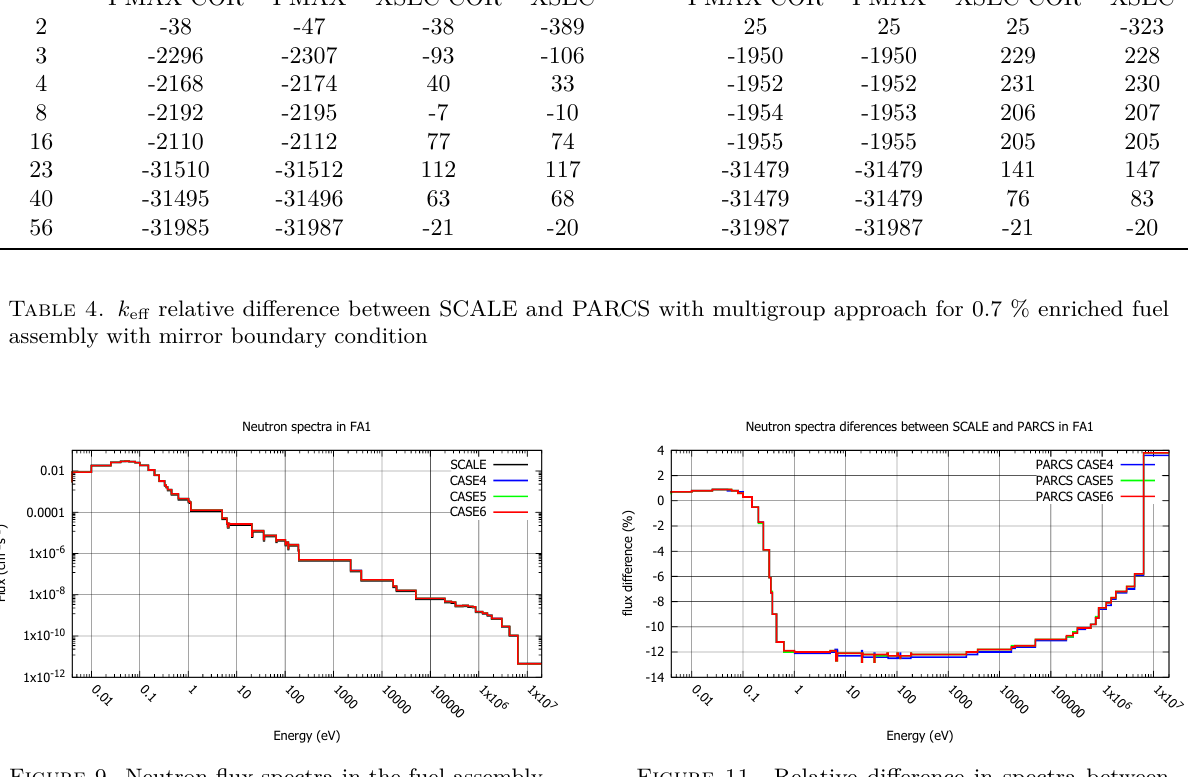
Figure 9. Neutron flux spectra in the fuel assembly FA1 with 0.7% fuel enrichment